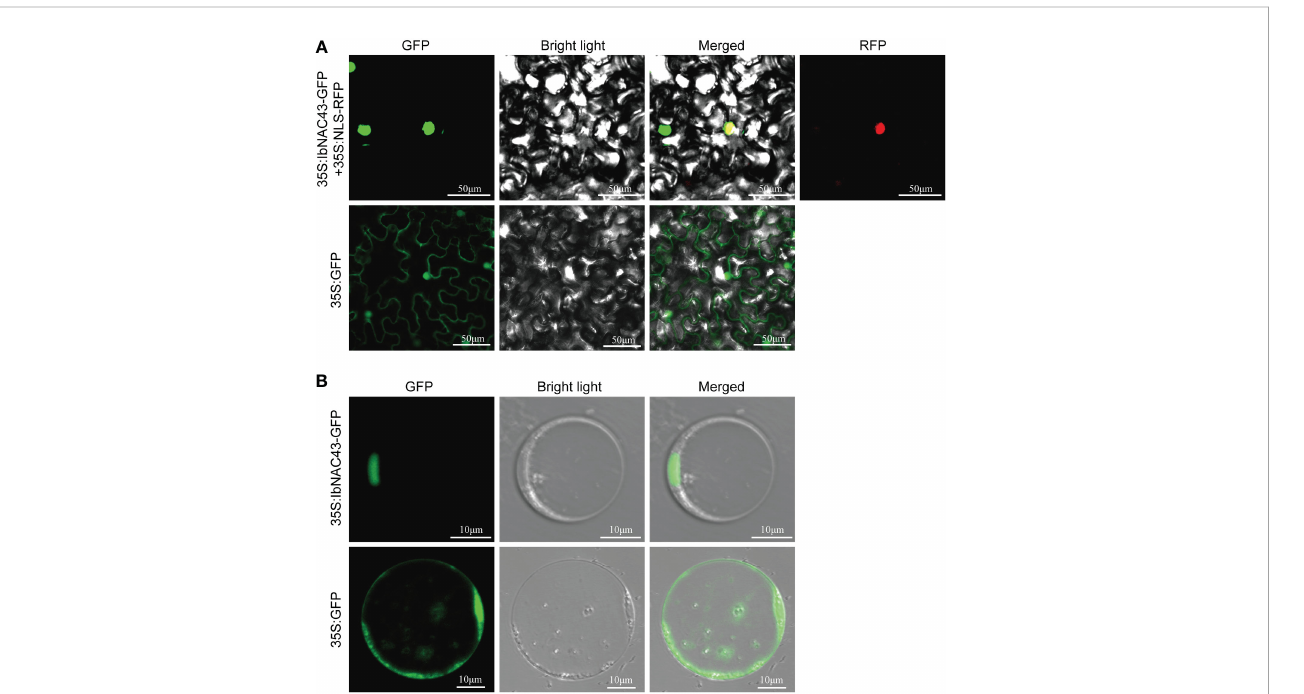
FIGURE 3 Subcellular localization of IbNAC43 in tobacco leaf epidermal cells (A) and rice protoplasts (B) . Confocal scanning microscopy images show that the 35S: IbNAC43-GFP fusion protein is localized in the nucleus, whereas the control 35S:GFP is not.